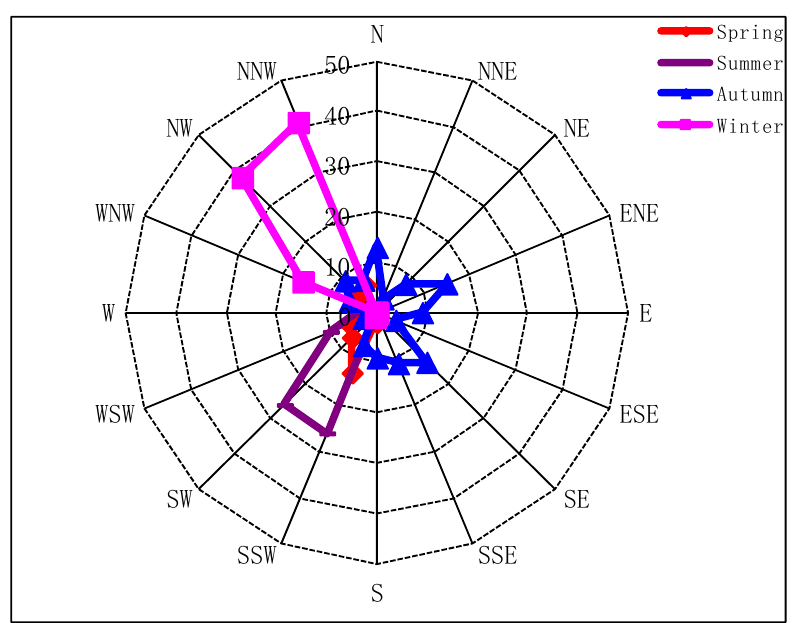
Figure 1. Wind frequency distribution in four seasons.